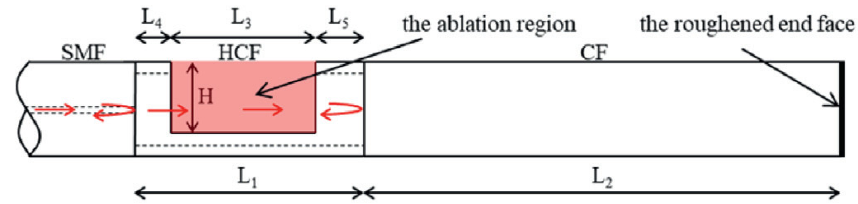
Figure 12. Fiber ‐ optic microcantilever ‐ based vibration sensor [95].